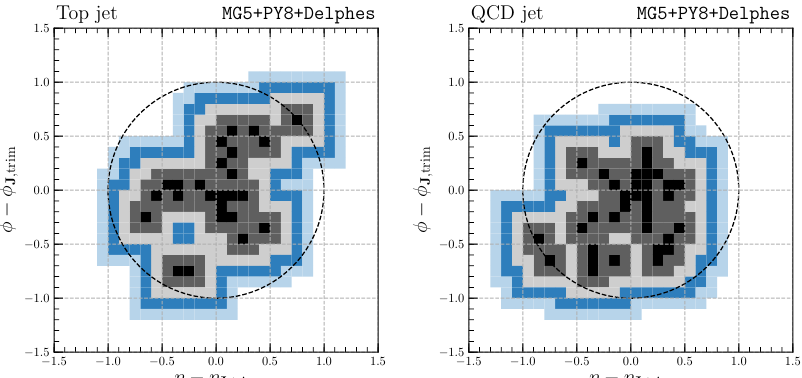
Figure 8. The Minkowski sum P ( i ) of the top jet image and QCD jet image. For each plot, black pixels belongs to P (0) dark gray, light gray, blue pixels are the di(cid:11)erence between P ( i ) (cid:0) P ( i (cid:0) 1) for i = 1 ; 2 ; 3,